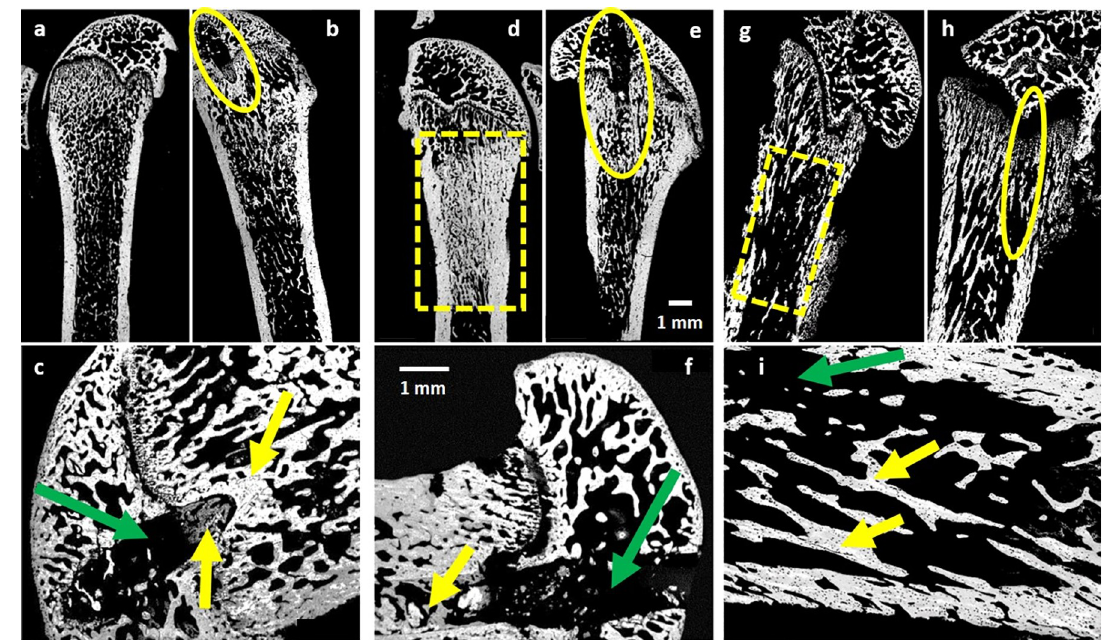
Fig 2. Backscatter electron images of rat femur. Representative sagittal cross-sectional BSE acquisitions. Regions of osteoblast proliferation, indicative of new bone formation, is seen post RFA (yellow arrows). Green arrows indicate probe insertion channels. a-c) Femora from healthy controls. d-f) Femora from ZR-75-1 cell injected rats: Osteoblastic-induced new bone formation is visualized identified inside the dashed rectangle box. g-i) Femora from HeLa cell injected rats: Osteolytic lesions in trabecular bone tissue demonstrate tumor involvement (i.e. dashed rectangular